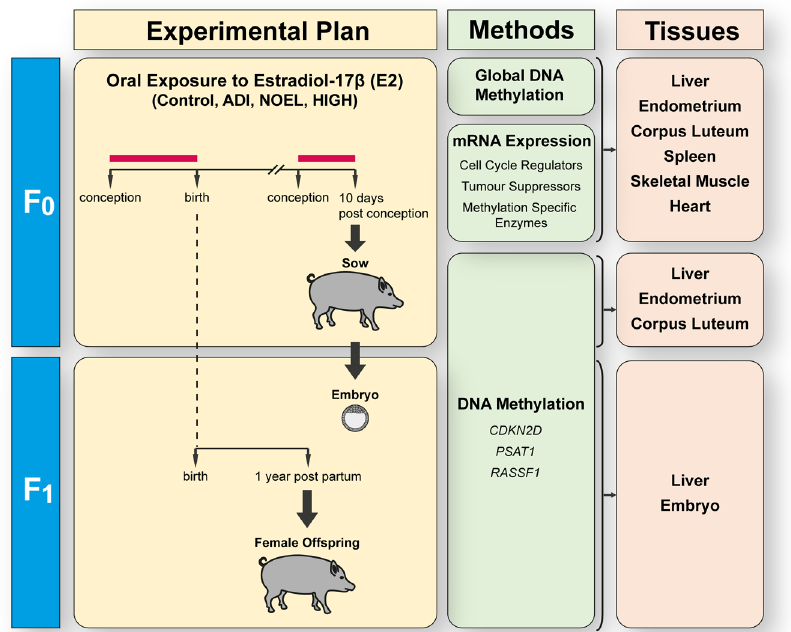
Figure 1. Summary of the workflow undertaken in this study. The experimental plan indicates the oral exposure to estradiol-17 β (E2) (indicated with red bars) at concentrations of 0, 0.05, 10 and 1000 μ g/kg body weight/day for the control, ADI – ‘acceptable daily intake level’, the NOEL- ‘no observed effect level’, and a HIGH dose, respectively. Pregnant sows (F 0 ) were exposed to treatments twice a day from conception to birth and again from conception to day 10 post-conception, after which they were slaughtered one hour after the last treatment. Embryos